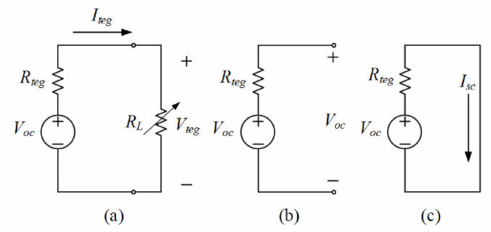
Figure 1. Deduction of the TEG